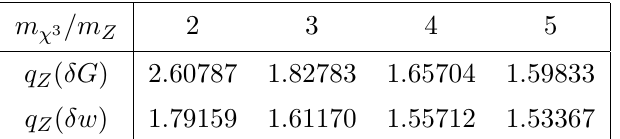
but not for smaller m . This is because (cid:31) 3 (cid:31) 3 (cid:31) 3